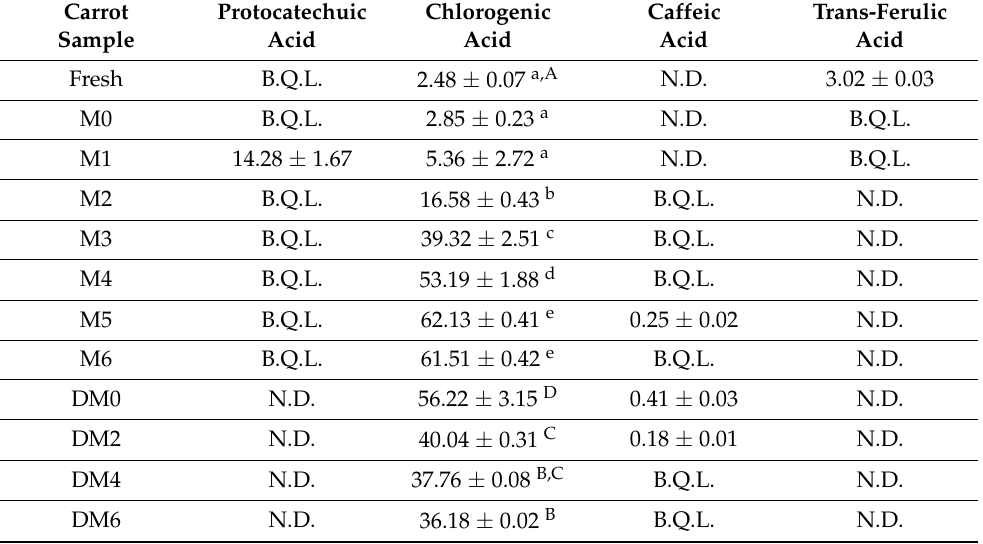
Columns with different superscript letters and corresponding to the same processing and storage approach are significantly different ( p < 0.05). Lowercase letters were used for fresh and frozen pulps forms while uppercase letters were used for fresh and dry powders forms. B.Q.L. = below the quantification limit. N.D. = not detected. M0 = 24 h after the freezing storage of pulps. M1, M2, M3, M4, M5, M6 = month one, two, three, four, five and